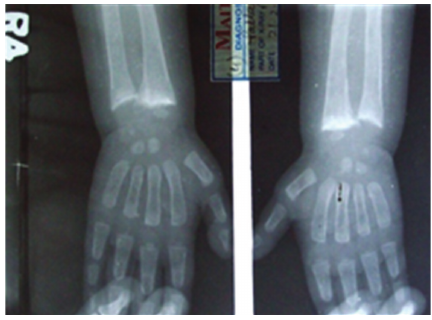
Figure 2: Showing wrist X-ray with features of active rickets.